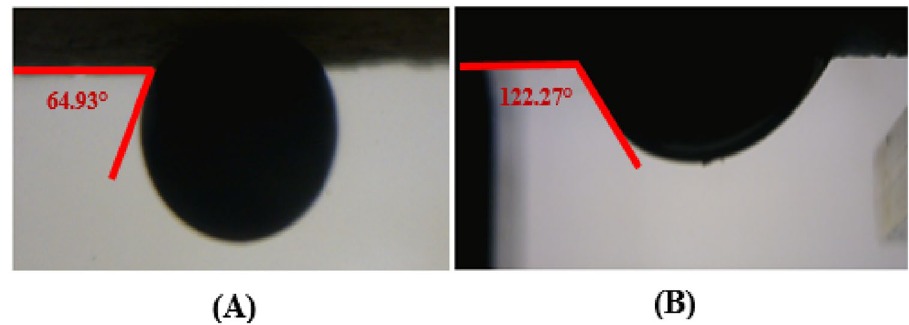
Figure 2. Images of contact angle changes of an oil droplet on the sandstone surface (A) before and ( B ) after wettability alteration with stearic acid and n-heptane.